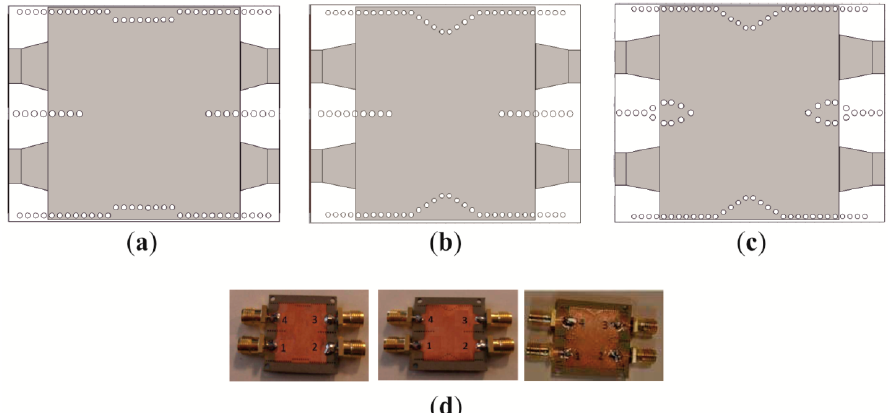
Figure 2. Examples of a four-port directional coupler designed in [29]. ( a ) Coupler #6; ( b ) Coupler #7, ( c ) Coupler #8; and ( d ) Photographs of the prototypes. Figures adapted from [28,29].